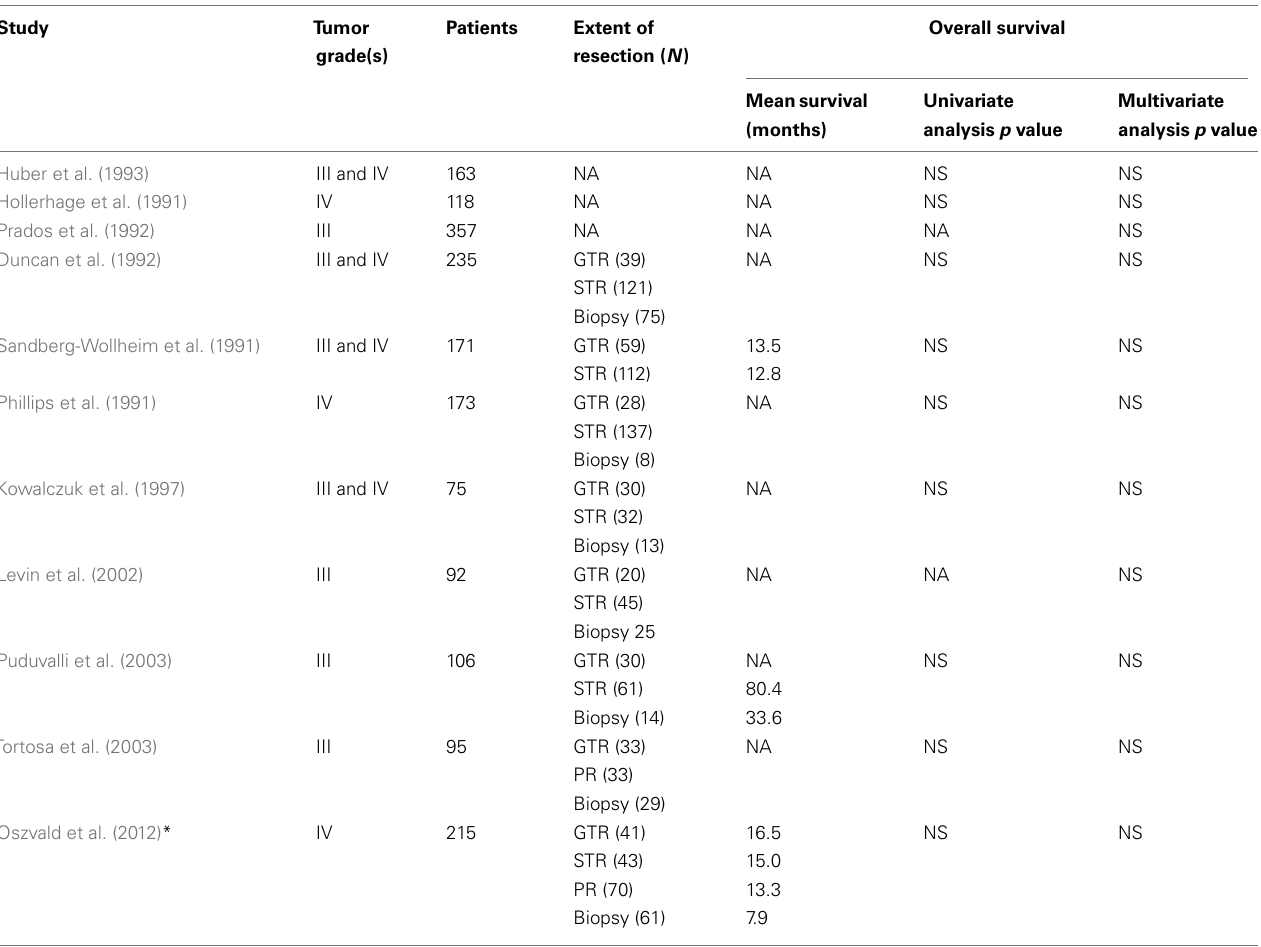
Table 3 | Negative, non-volumetric studies of EOR in high-grade glioma.